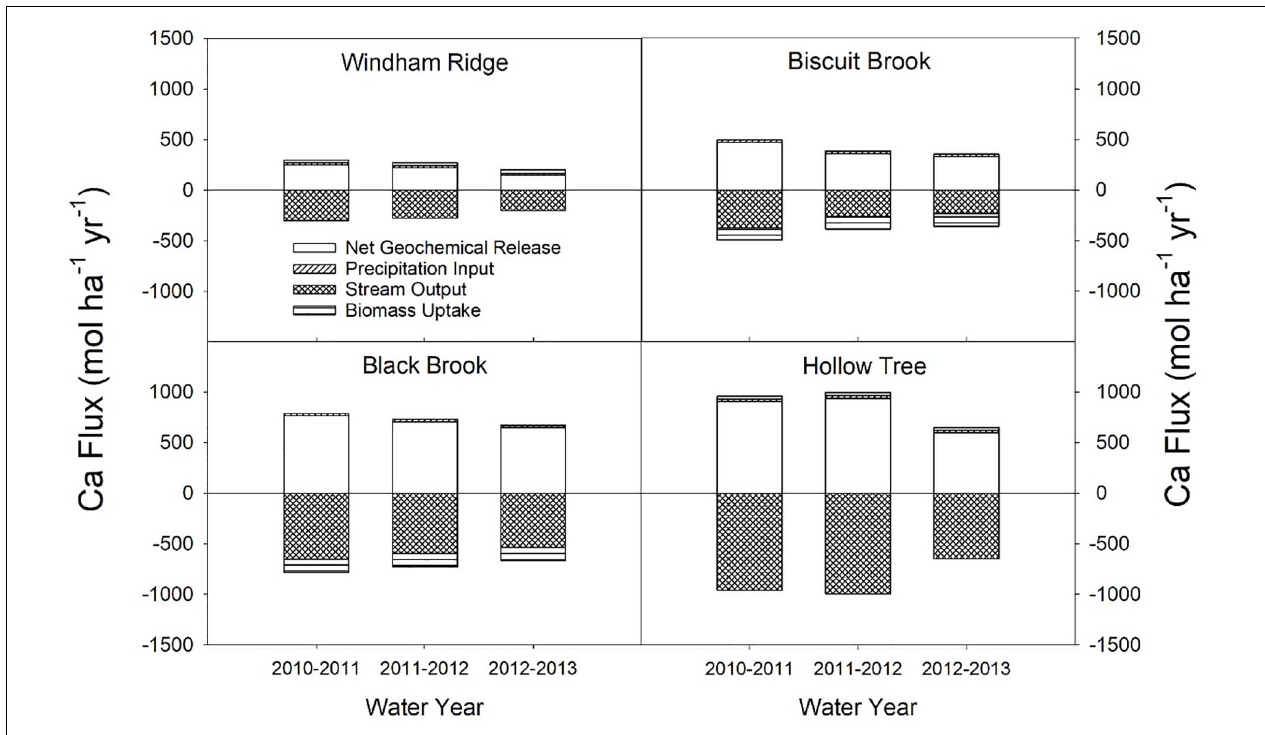
FIGURE 4 | Terms used in calculating the net geochemical release rate of Ca using the mass-balance method in four watersheds (mol ha - 1 yr - 1 ). Positive values indicate sources of Ca and negative values indicate sinks. Windham Ridge had the lowest net geochemical release rate for Ca in the study, while Hollow Tree had the highest. Note that biomass uptake may be either a source or sink of base cations depending on whether the forest is declining or aggrading.